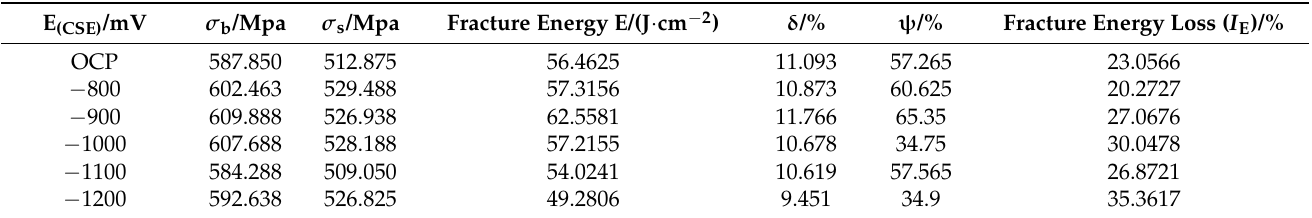
Table 3. The tensile properties of X80 under different CP potentials in soil medium at 45 ◦ C.